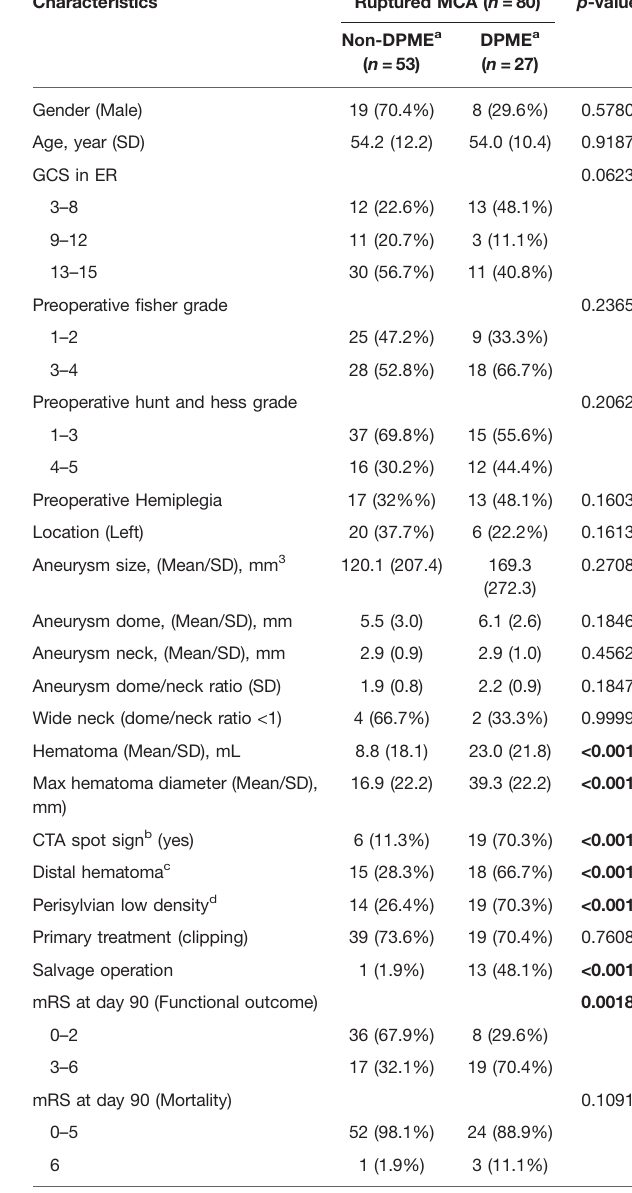
Bold values indicate statistical signi fi